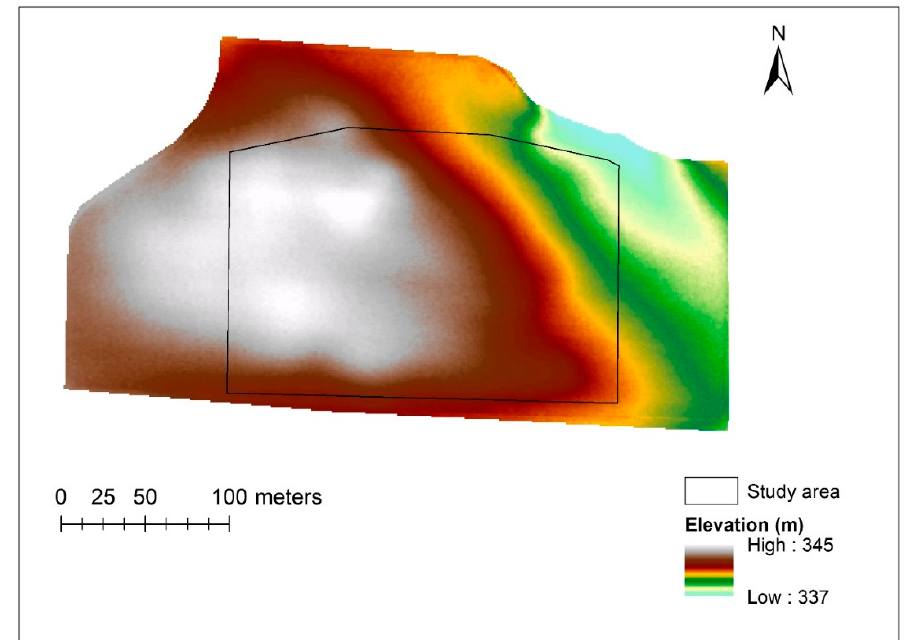
Figure 8. Digital elevation map of the study site. (Source: Minnesota Department of Natural Resources and Minnesota Geospatial Information Office, (MnTOPO) [58]).